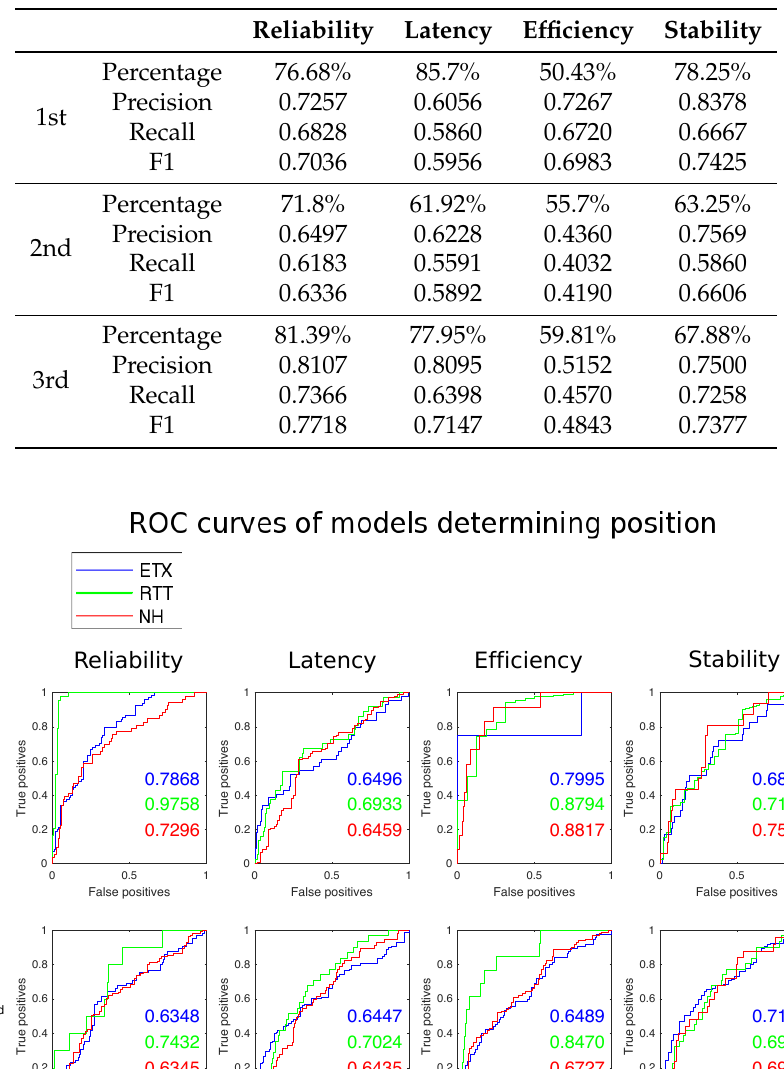
Table 3. Model accuracy over a test data set.